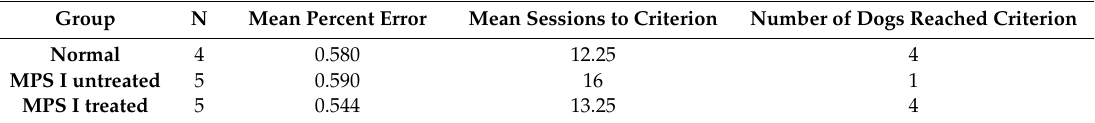
Table 13. Reversal learning descriptive statistics for each group. This includes the number of dogs tested (N) from each group, mean (real) percent error of each group, mean (real) number of sessions performed by each group, and number of dogs from each group that reached the criterion.